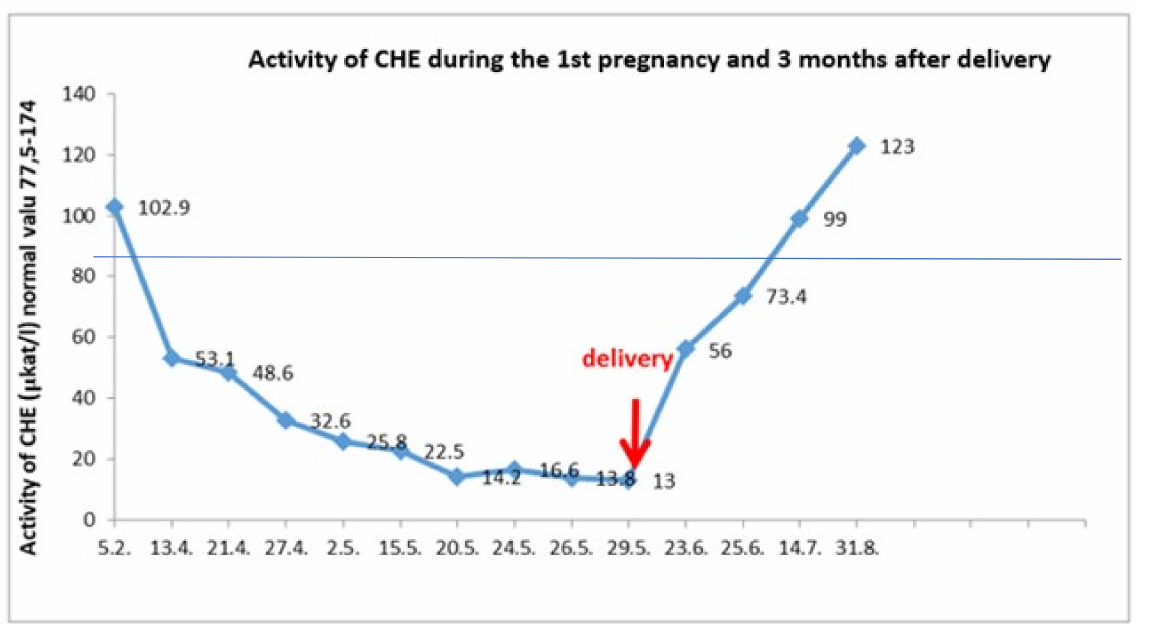
Figure 2. Cholinesterase plasma values during the first pregnancy. At the prenatal visit in April 2015, a decreased albumin level was recorded. Since then, CHE level and other synthetic liver function indicators had been progressively decreasing, coagulation factor V in particular. After delivery, these parameters were spontaneously improving without a treatment modification, and after seven weeks they were completely